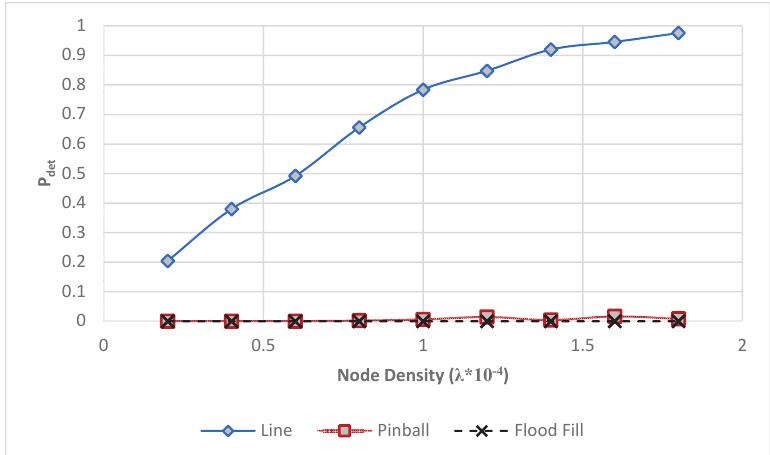
Figure 7. The detection probability P det of an intruder that adopts the linear, pinball and flood-fill algorithms in a WSN with varying node densities λ